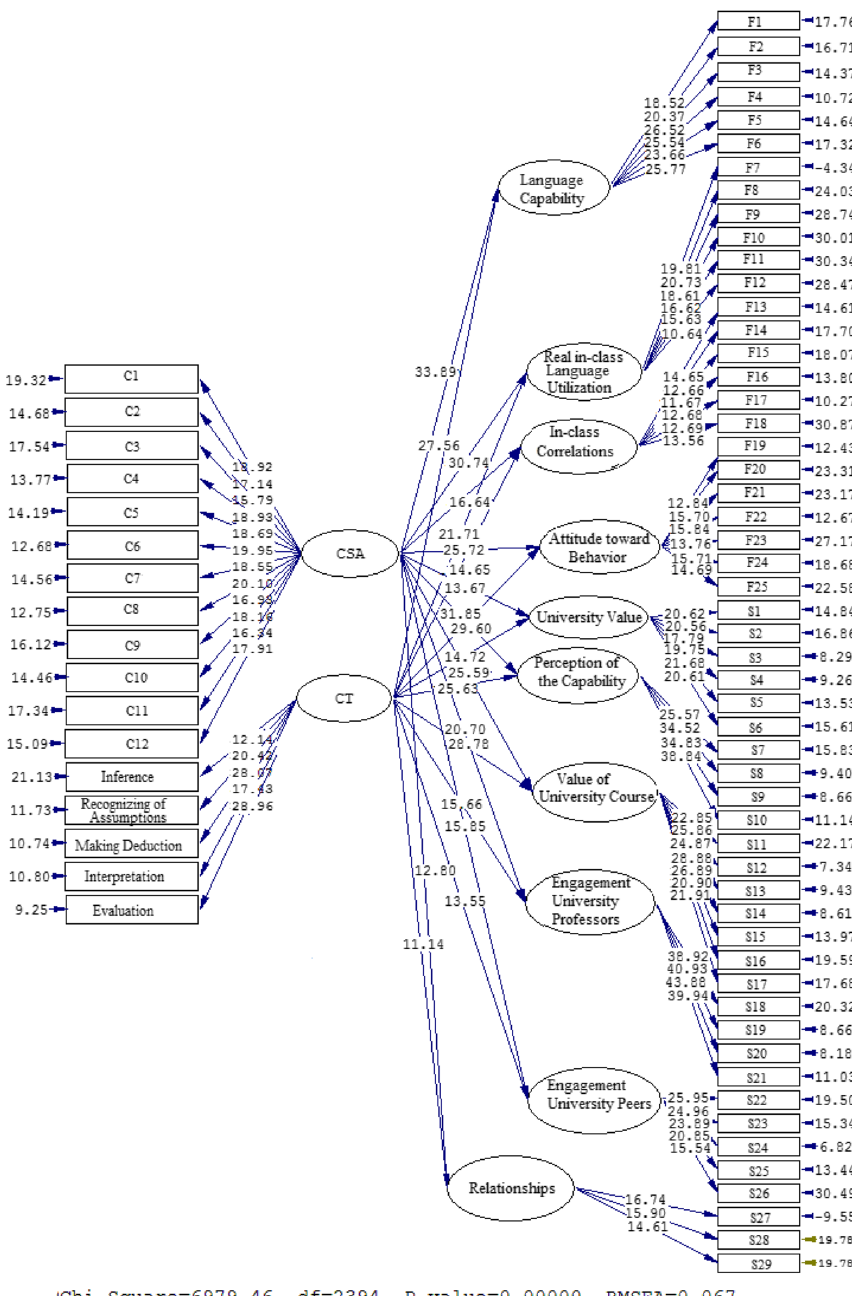
Fig. 5 T values for path coefficient significance (model